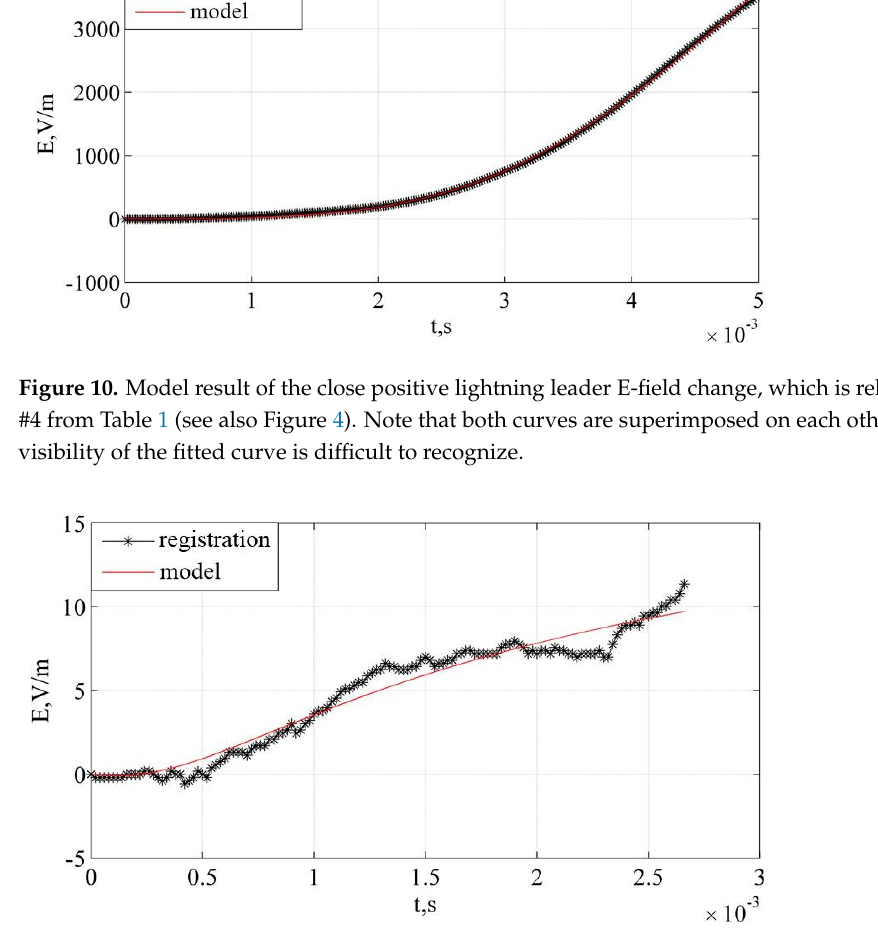
Figure 11. Description is the same as in Figure 10, except the middle distance positive lightning leader E-field change, which is related to Case #7 from Table 1 (see Figure 6).